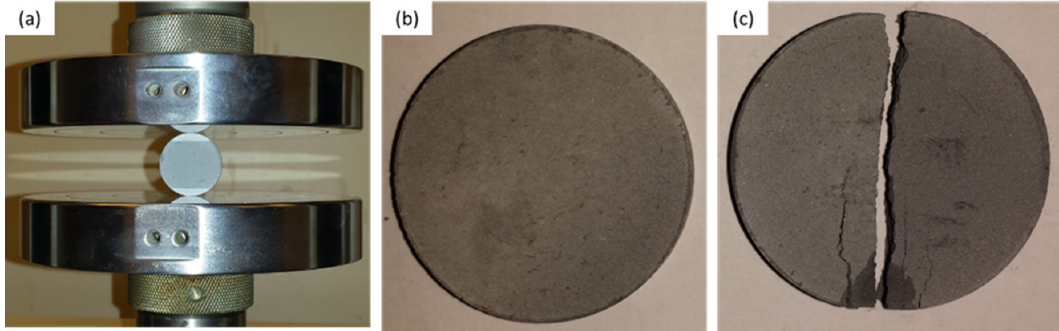
Figure 9. Diametrical compression testing: ( a ) configuration, ( b ) membrane sample before the test, and ( c ) fractured membrane after the test .